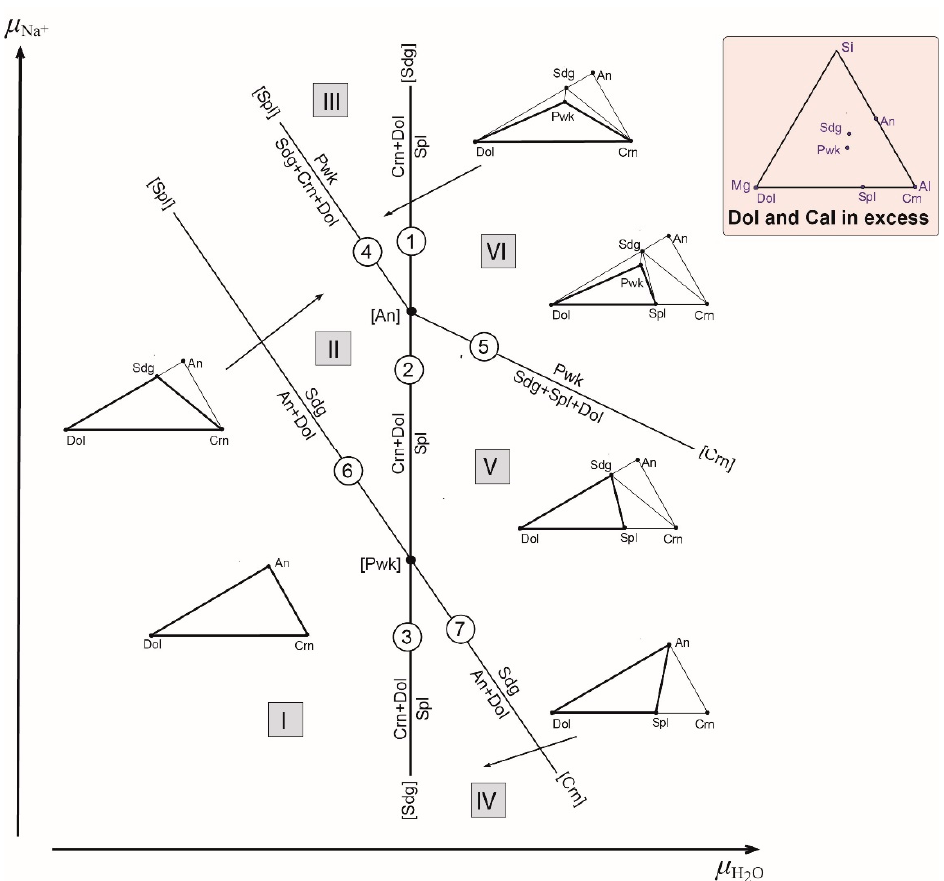
Figure 7. Qualitative µ H 2 O diagram of mineral parageneses of preiswerkite in the system Na-Mg-Al-Si-CO 2 -H 2 O. I, II, III, IV, V, VI—stable divariant fields; the numbers in circles indicate the reaction numbers in the Table 6.